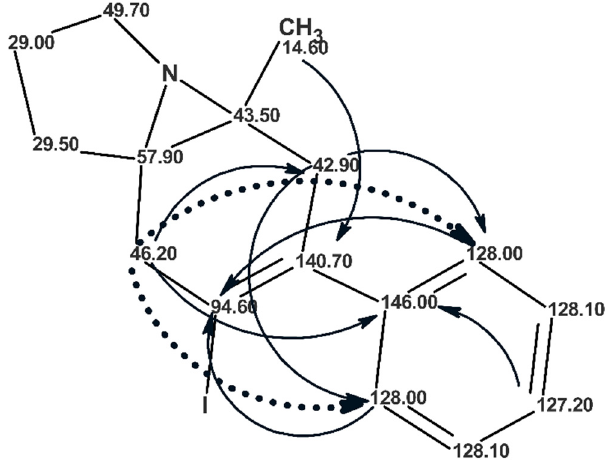
Figure 16. Suggested structure of a reaction product. The arrows show the nine 1 H- 13 C HMBC NSCs. The connectivities from 46.2 to 128.0 marked by dotted arrows correspond to 5 J CH .